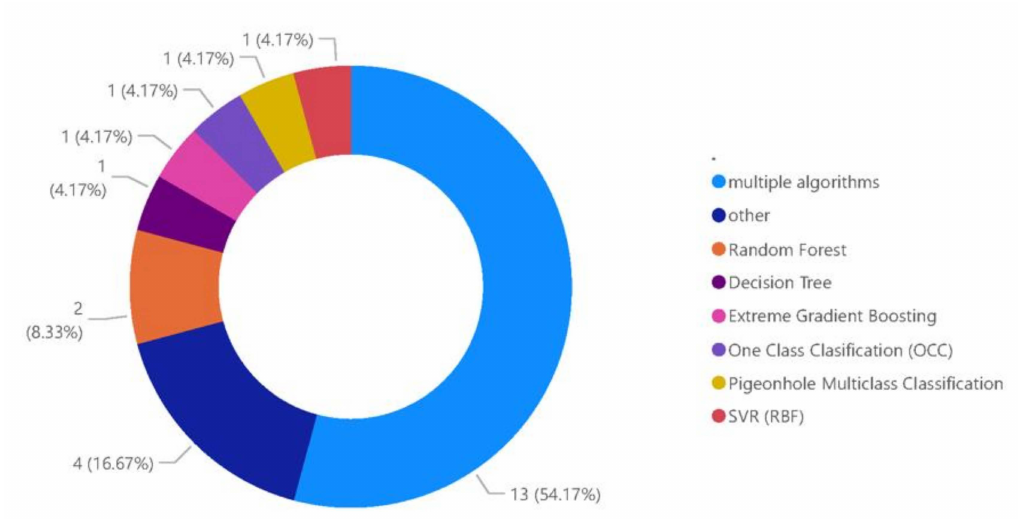
Figure 10. Distribution of algorithms in the papers using supervised